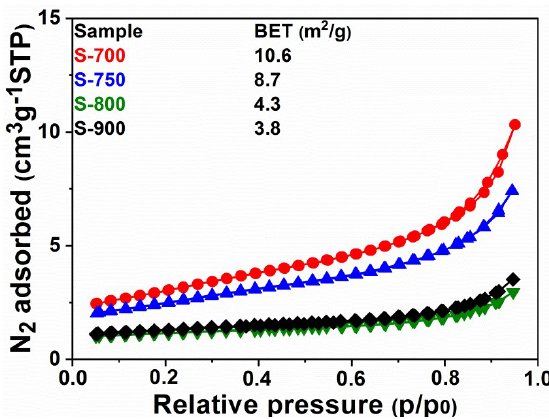
Figure 5. N 2 adsorption-desorption isotherms for LaFeO 3 samples and the resulting BET surface areas of the different samples.